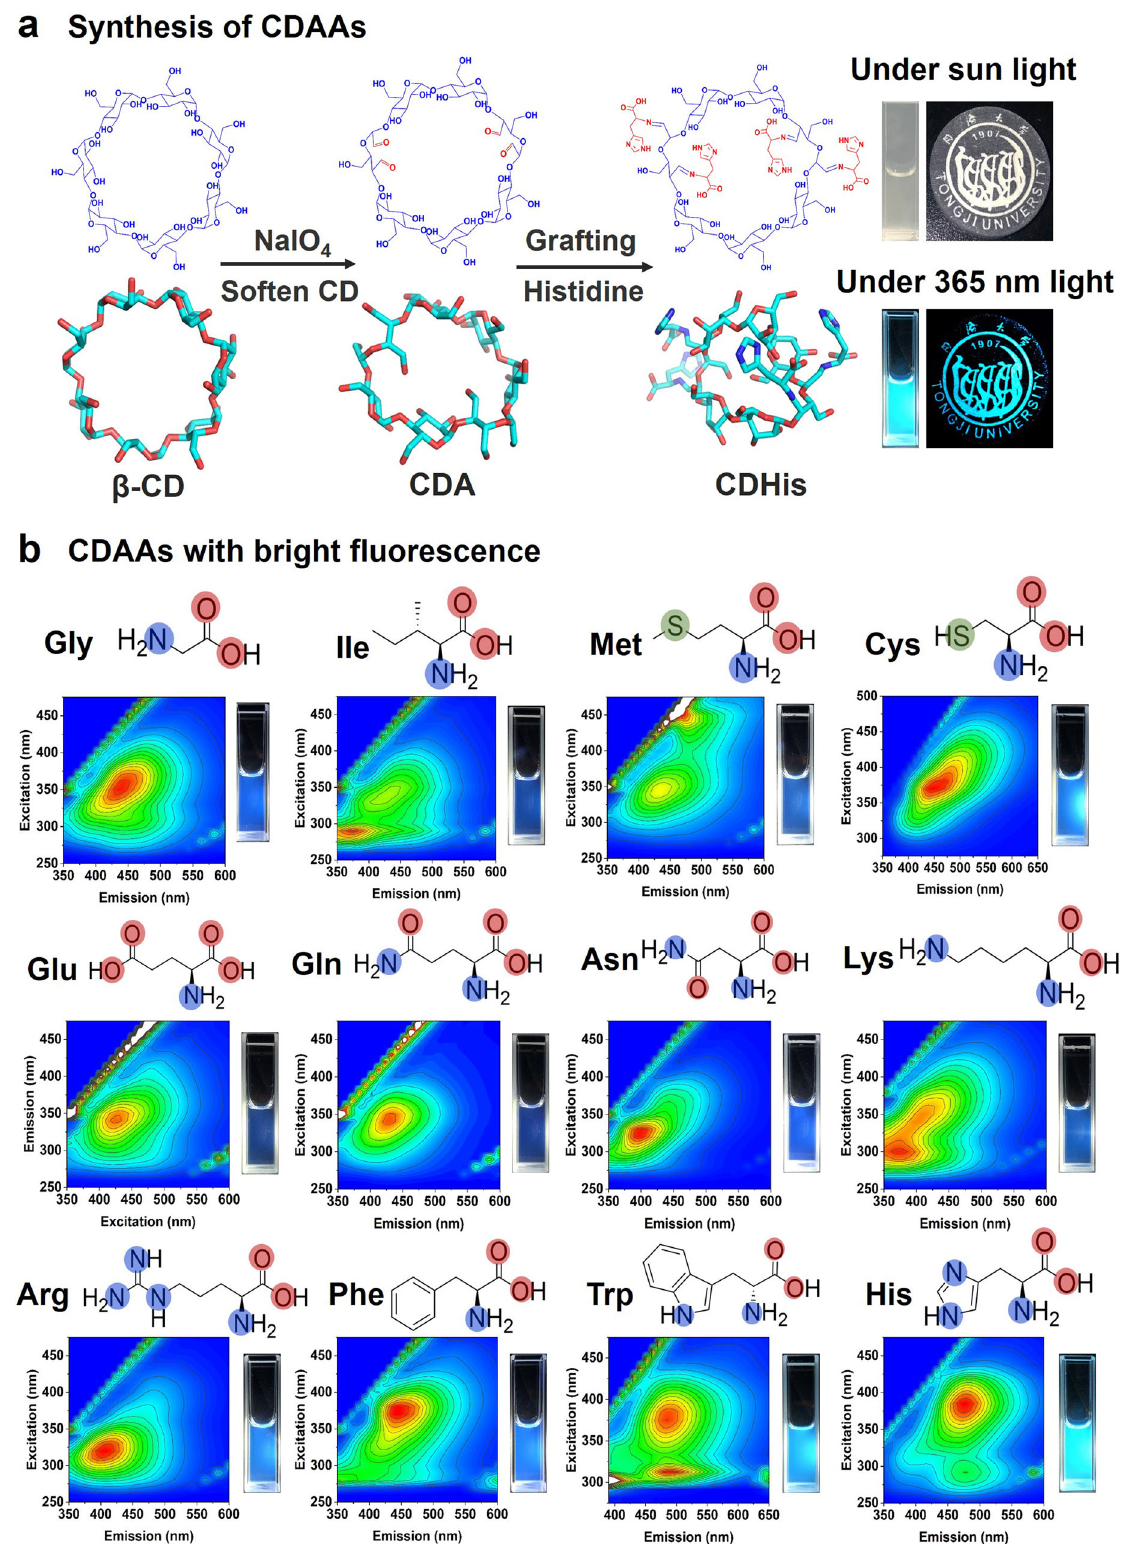
Fig. 1 | Synthesisofhighly luminescent CDAAs. a Syntheticroute of luminescent CDAAs(histidine as example) from the conjunction of β -CD and aminoacid.Right: photos of CDHis in aqueous solution (1.0mM in H 2 O) and powder phase under